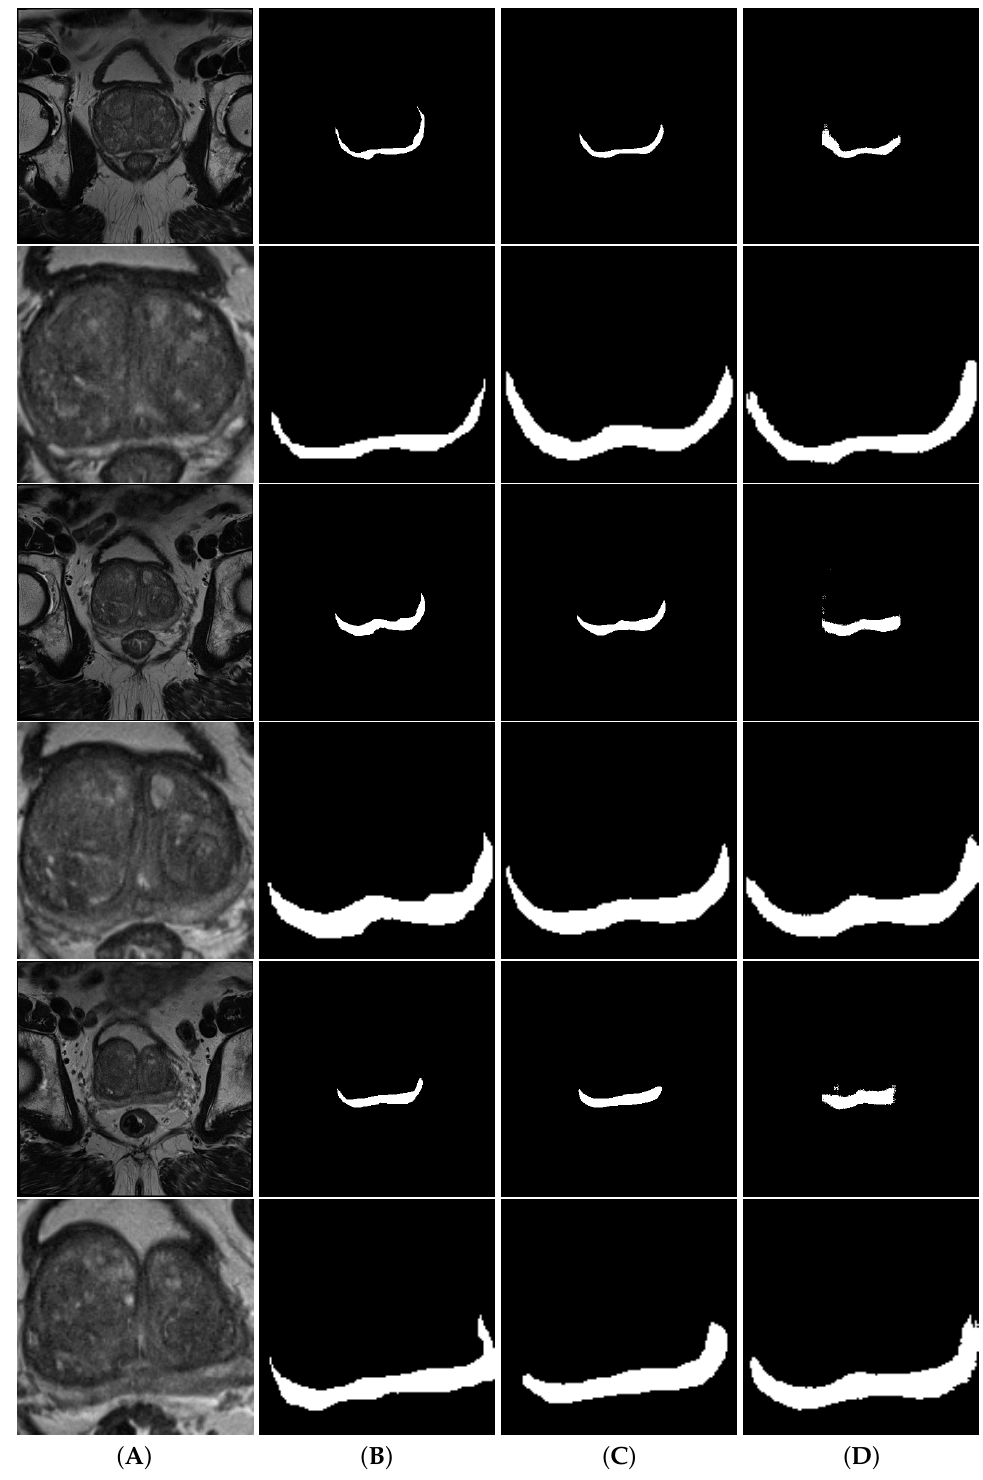
Figure 9. Segmentations of the peripheral zone. Column ( A ) contains the volumes, column ( B ) contains the ground truth, column ( C ) contains the nnU-Net segmentations and column ( D ) contains the highResNet segmentations. Rows are interleaved, showing a full volume and a model cropped by the object detection model,